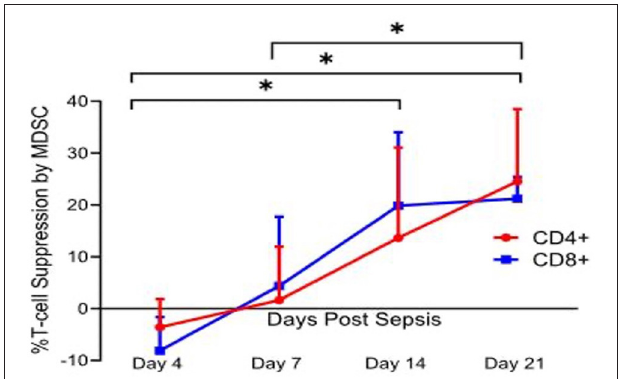
FIGURE 3 | Percent T lymphocyte suppression by MDSCs. Immature myeloid cells with the surface markers CD33 + CD11b + HLA-DR dim were isolated on days 4, 7, 14, and 21 after sepsis, and from healthy control subjects. Autologous T lymphocytes were stimulated with soluble anti-CD3/28 and seeded in a co-culture with MDSCs in a 1:1 ratio. T cells were labeled with CellTrace Violet to detect proliferation, and a proliferation index (PI) was calculated for both CD4 + and CD8 + T cells using flow cytometric analysis. Percent suppression was calculated as the ratio of PI from stimulated T cells in the presence of MDSCs and the PI of stimulated T cells in culture medium alone. Percent suppression for both CD4 + and CD8 + T cells was significantly different between day 4 vs. 14 ( p = 0.0402 and 0.0012), day 4 vs. 21 ( p = 0.0225 and < 0.0001), and day 7 vs. 21 ( p = 0.037 and 0.045). There was no significance noted of percent suppression of CD4 + and CD8 + T cells between days 7 and 14 ( p = 0.17 and 0.08). This T cell suppression was not seen in age-matched healthy control subjects. Modified from Hollen et al. ( 62). *indicates statistically significant intervals ( p < 0.05).